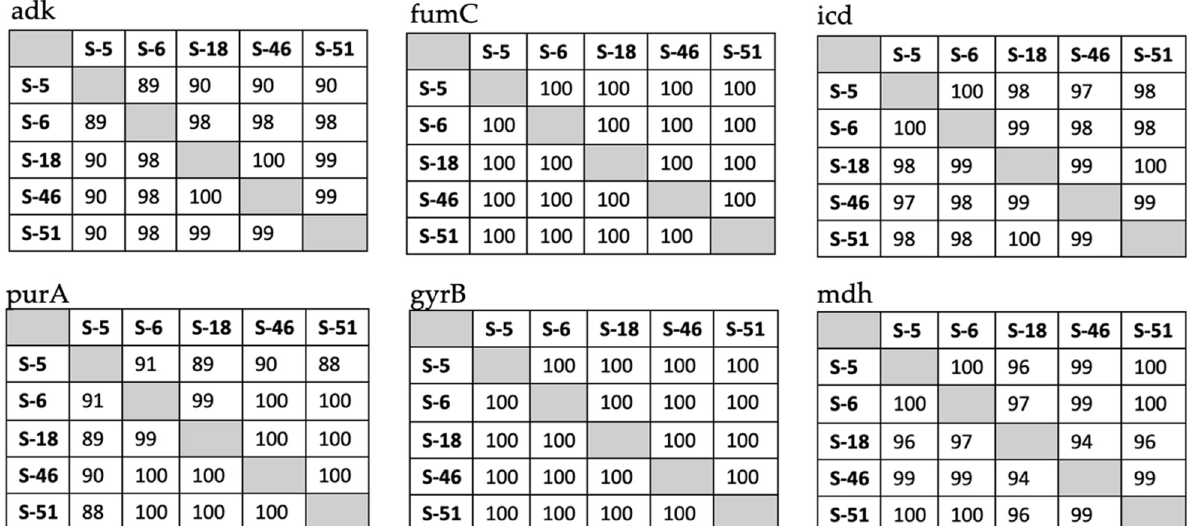
Figure 2. Nucleotide similarity between chicken samples (S18, S46, and S51) and human samples (S5 and S6).